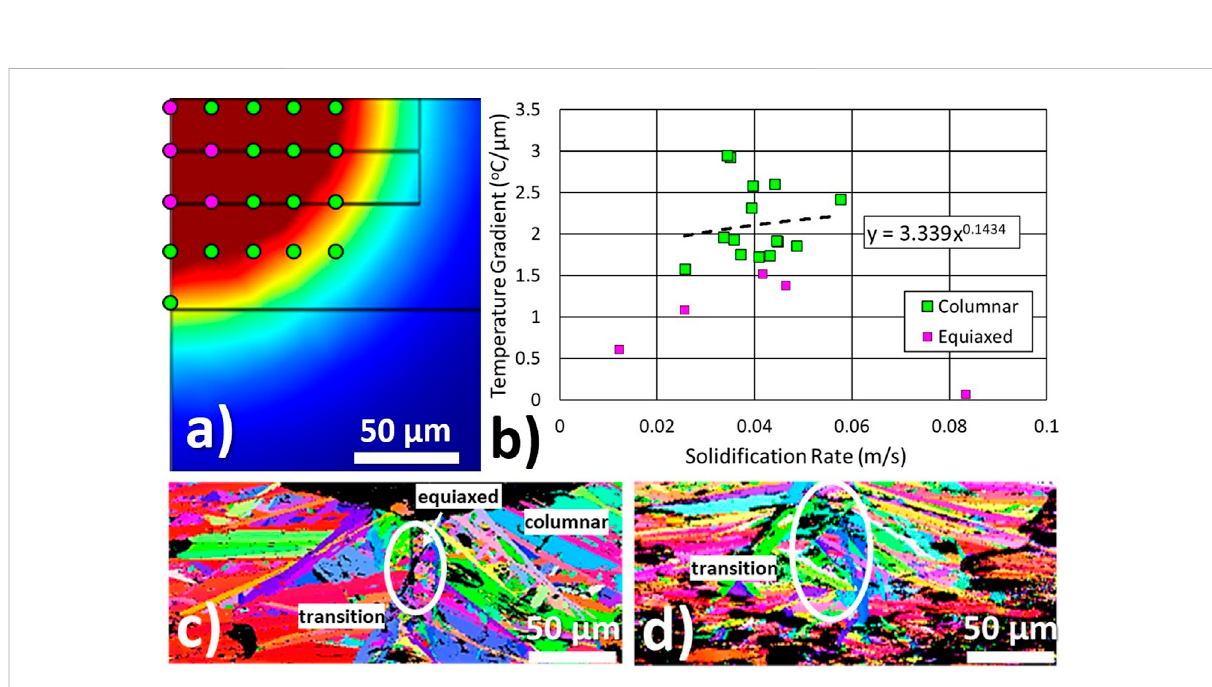
FIGURE 10 (A) Thepointswheretemperaturegradient G andsolidi fi cationrate R datawerecalculated.Computationalcolumnartoequiaxedtransitionlimit occurs around the points colored in purple, (B) Computational G-R data, (C) EBSD image showing the computational columnar to equiaxed transition limit for the sample used in simulations (25 W, 350 mm/s, single scan), (D) EBSD image of the same sample with 5 scans showing a larger columnar to equiaxed transition